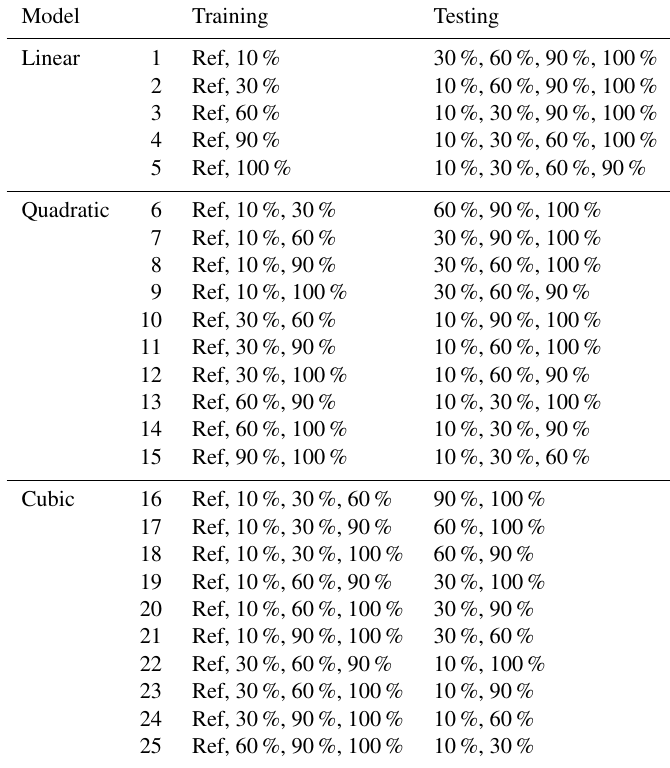
Table 1. List of CTM sensitivity simulations used to train and test the various linear, quadratic and cubic forms of the surrogate model. Model Training Testing Linear